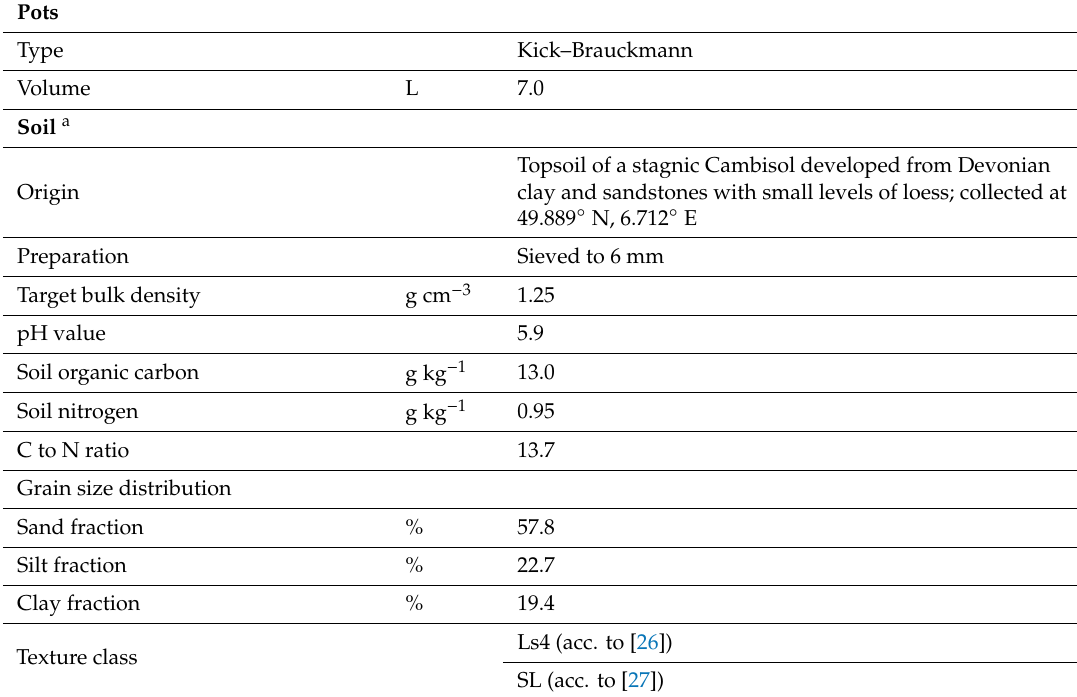
Figure 1. Scaled, schematic depiction of the Kick–Brauckmann plant culture pots with subdivision into ‘Top’ and ‘Bottom’ layers and installation position of the Frequency domain FD sensors for determination of volumetric water contents. Table 1. Characterization of the experimental